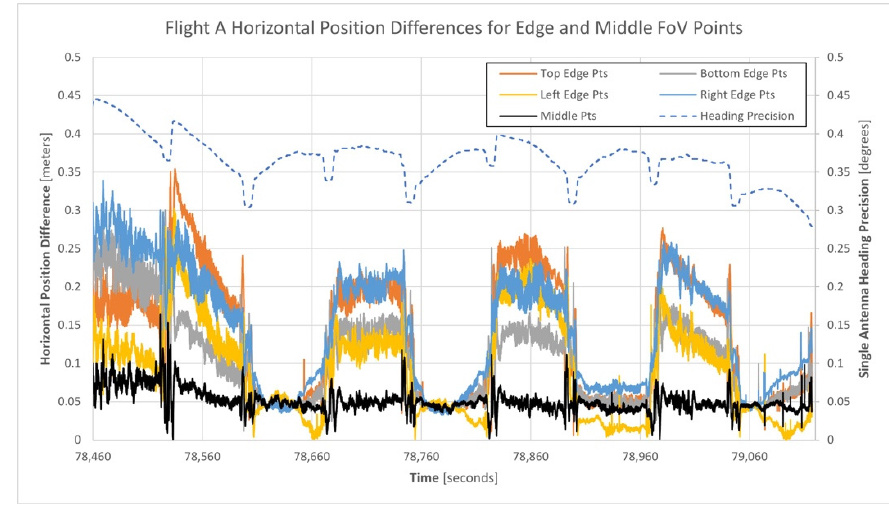
Figure 14. Horizontal position differences between the single and dual-antenna generated point clouds for the five regions of points of flight A.